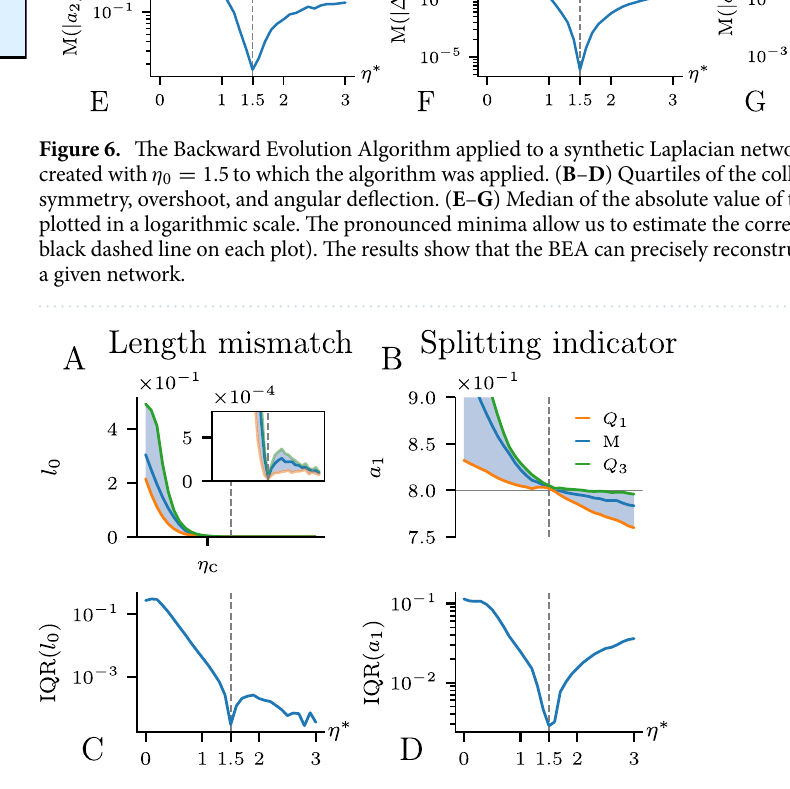
Figure 7. Analysis of the bifurcation points in the BEA: length mismatch ( l 0 ) and a 1 coefficient at the splitting point as a function of the growth exponent ( η ∗ ). ( A – B ) Quartiles of the values of a corresponding metric. ( C – D ) Interquartile range of the distributions (distance between Q 1 and Q 3 ). The results confirm that the